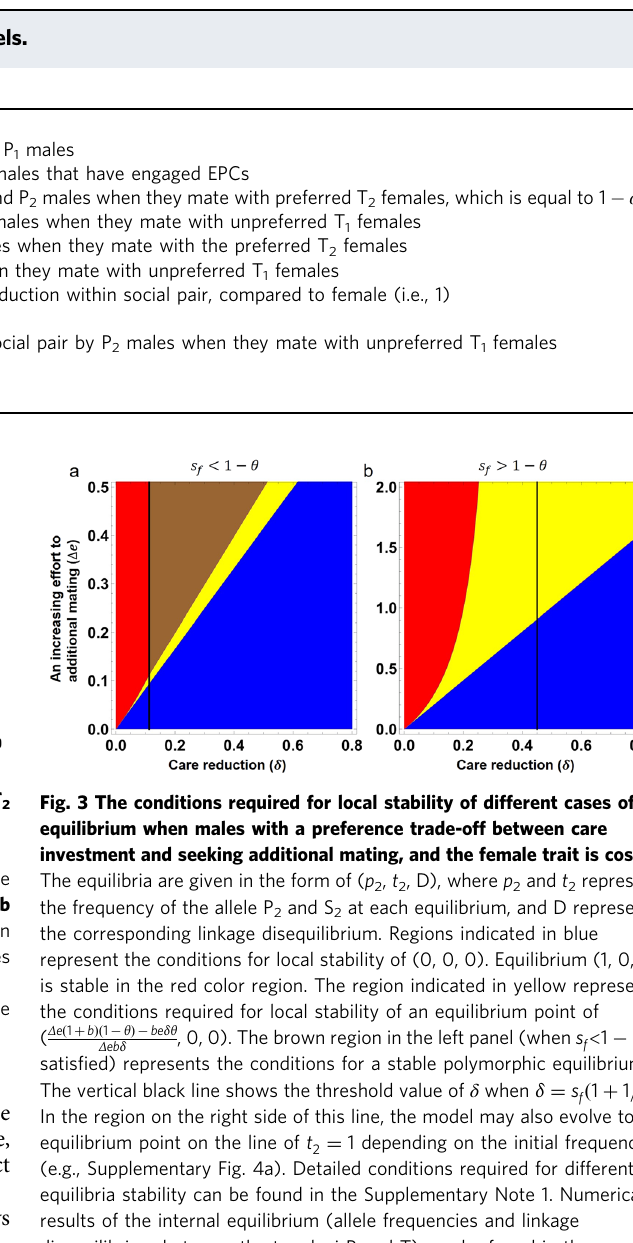
Supplementary Fig. 5. We set s f ¼ 0 : 05 and θ ¼ 0 : 7 in ( a ), s f ¼ 0 : 2 and θ